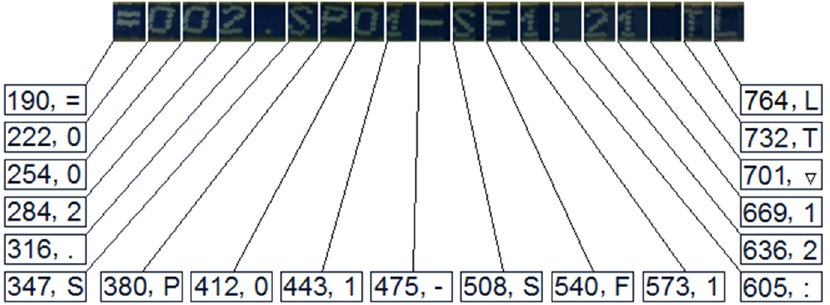
Figure 16. The isolated characters on the wire marking image.